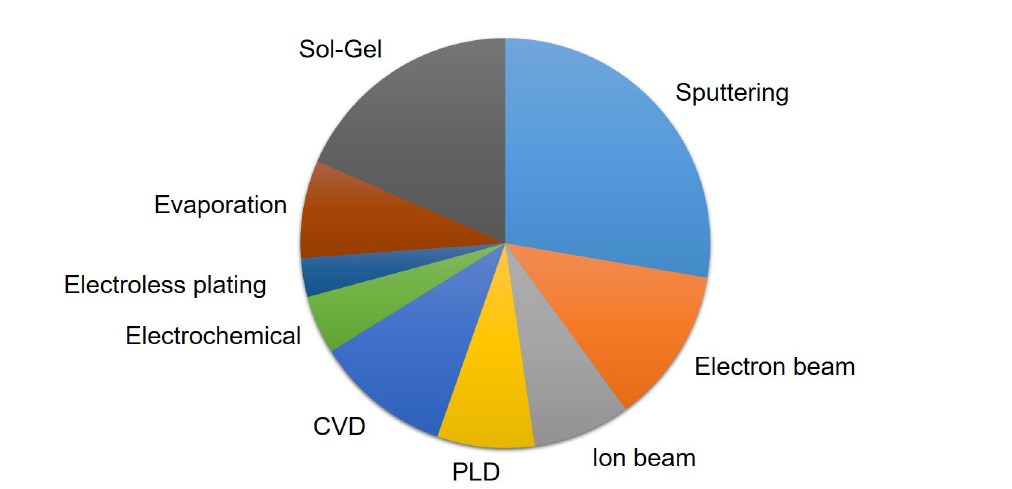
Figure 7. The pie chart of the fractal surface preparation